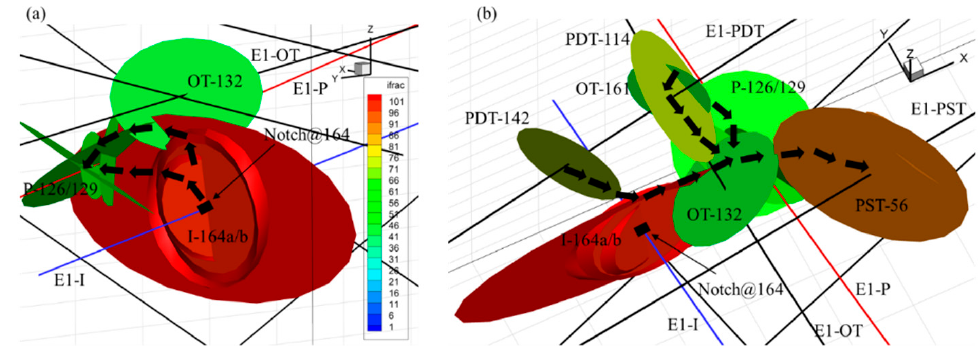
Figure 14. The results from numerical simulation: ( a , b ) show the fracture and matrix pressure at T22:52; ( c , d ) is the propagation of I-164b at T22:52. I-164b fully intersects OT-132, P- 122/126/127/129 and E1-P. Injection well E1-I fully connects with production well E1-P. ( e , f ) are transparent views of the fracture network. Unit: MPa.